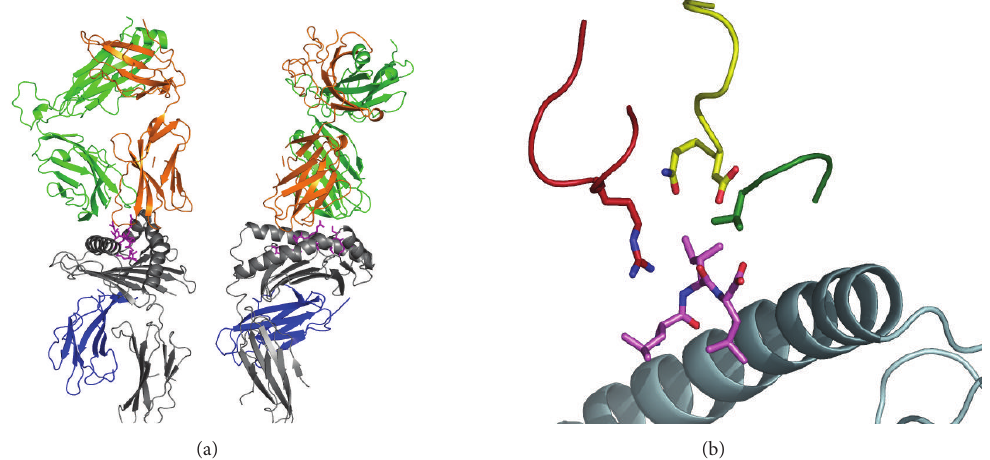
Figure 2: Crystal structure of the HLA-E/KK50.4 TCR complex [12]. (a) Overview of the HLA-E/KK50.4 TCR structure showing two orthogonal views. The HLA-E heavy chain is shown in grey ribbons, the UL40 peptide in pink sticks, and 𝛽 2m in blue ribbons. The KK50.4 alpha and beta chains are shown as orange and green ribbons, respectively. (b) The convergence of all 3 CDR 𝛽 loops onto P8 Ile of the peptide bound to HLA-E. The HLA-E heavy chain is grey, peptide is pink, CDR1 𝛽 is yellow, CDR2 𝛽 is green, and CDR3 𝛽 is shown in red.